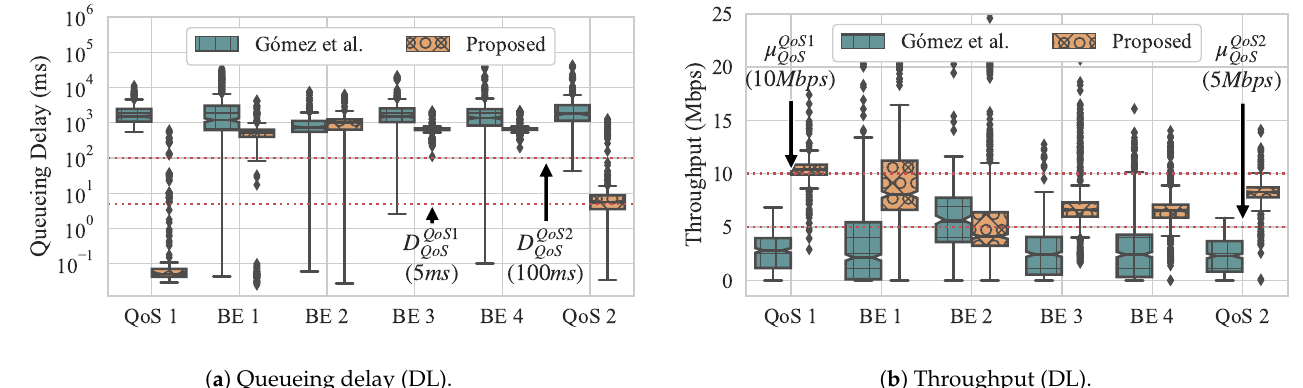
Figure 12. Experiment 2 box-and-whiskers plots. ( a ) Overall queueing delay of slices (DL); and, ( b ) overall throughput of slices (DL).